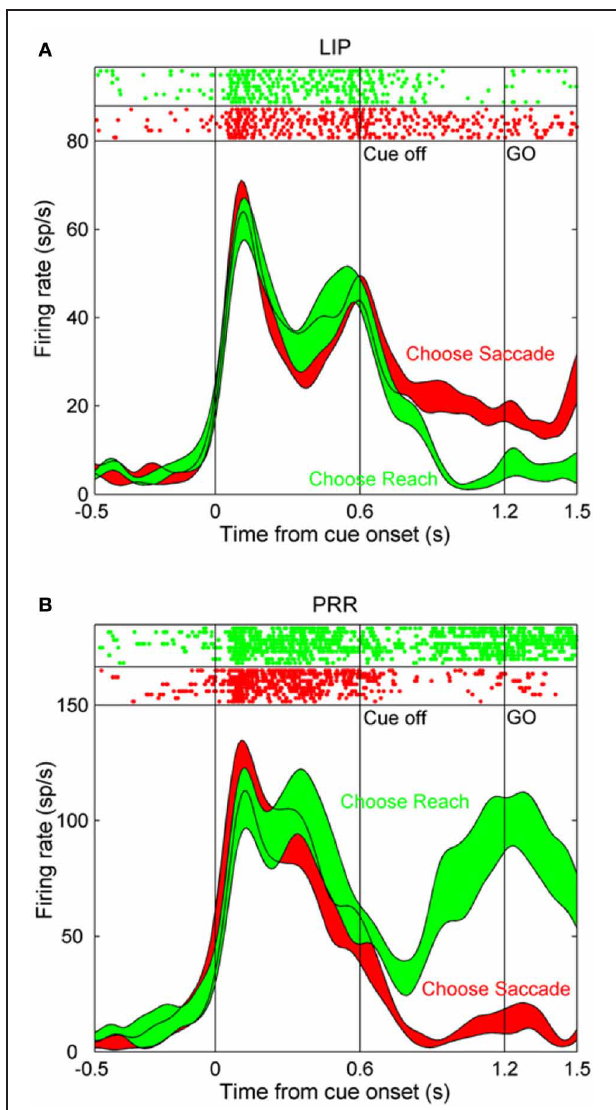
FIGURE 1 | The activity of single neurons in the lateral intraparietal (LIP) area and in the parietal reach region (PRR) during a task in which monkeys autonomously decided to make a saccade or a reach toward the same remembered visual target location. (A) After the initial visual transient at the onset of the peripheral cue, activity in this LIP neuron is greater during the following delay period on trials that the monkey decided to make an eye movement (red trace) than an arm movement (green trace). (B) Corresponding data in a PRR neuron. Activity in this case was greater on trials that the monkey decided to make an arm movement relative to a saccade. Reprinted with permission (Cui and Andersen, 2007).